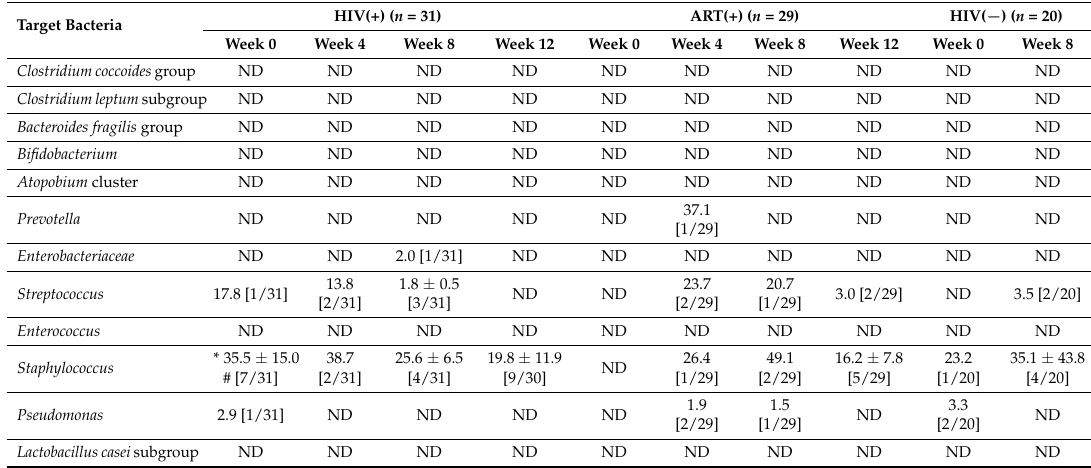
Table 1. Detection of 16S/23S rDNA in plasma before and after LcS ingestion and detected frequency. Target